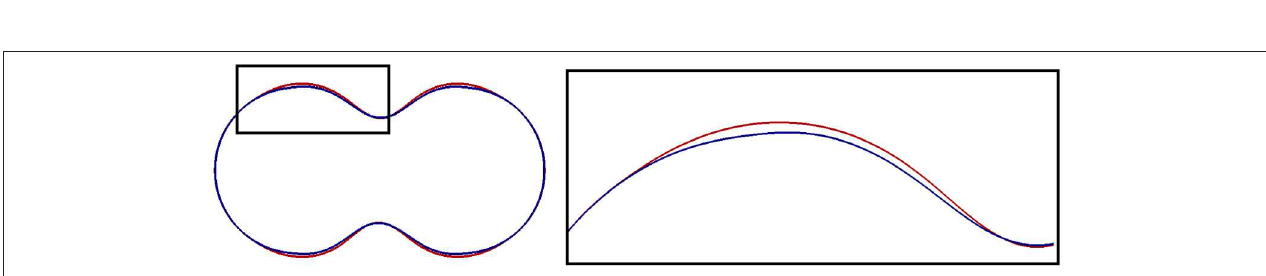
Frontiers in Applied Mathematics and Statistics |